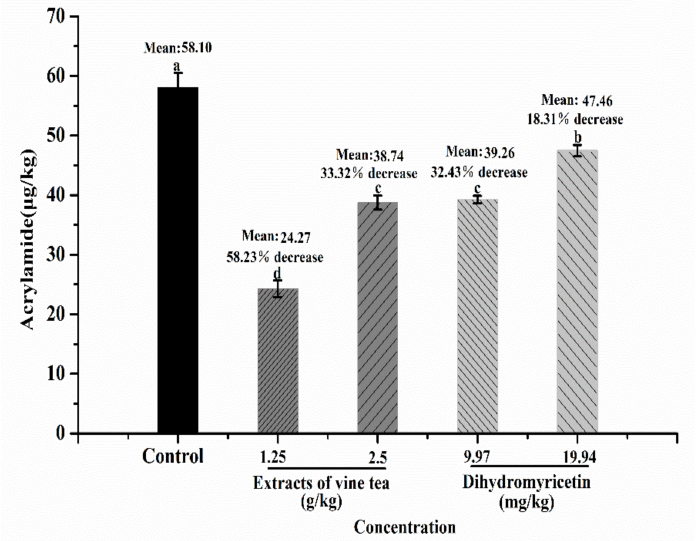
Figure 2. Contents of acrylamide in the crust of sample bread (vine tea extract or dihydromyricetin) and control bread (without supplement): The results are expressed as mean ± SD ( n = 3). Di ff erent letters indicate significant di ff erences ( p <